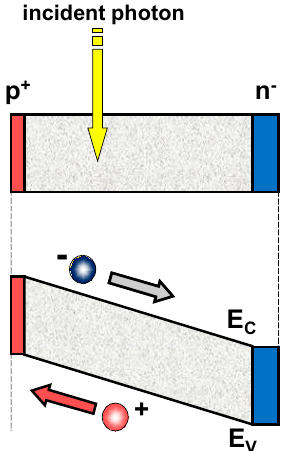
Figure 1. Schematic of modern silicon solar cell. Light absorbed in intrinsic region and creates free electron-hole pairs. The built-in electric field separates charges with holes migrating to the p-doped region and electrons migrating to the n-doped region; resulting in a tilting of the conduction (E C ) and valence (E V ) energy bands in the